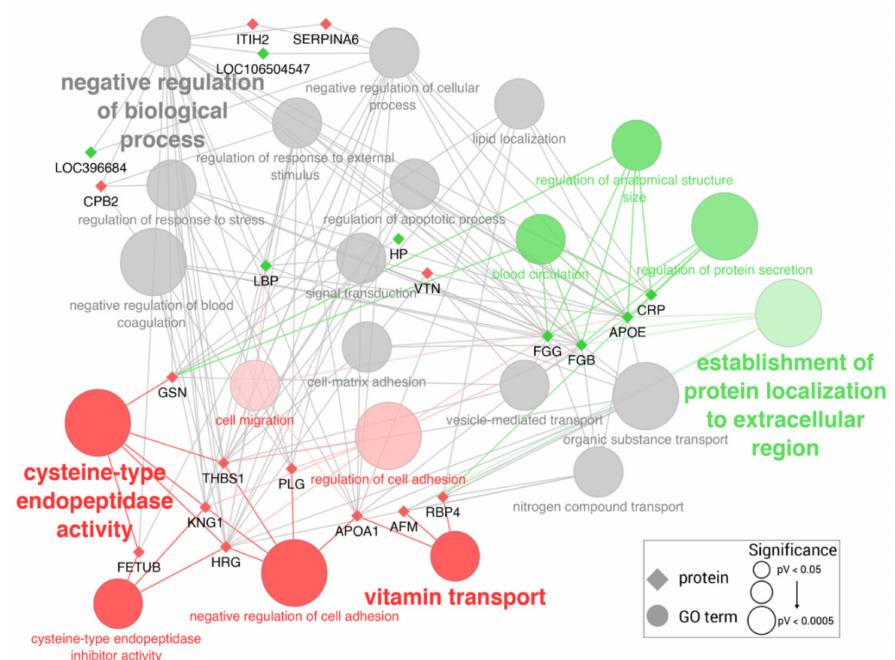
Figure 2. Significantly enriched GO terms among differentially expressed proteins in the serum of pigs with sepsis. Edges link proteins (diamonds) to their associated GO terms (circles). Proteins are colored in green if overexpressed or in red if down-expressed. GO terms are colored accordingly to the proportion of over-/down-expressed proteins. GO term shape and font size is proportional to GO term significance, but all included ones showed a p value <